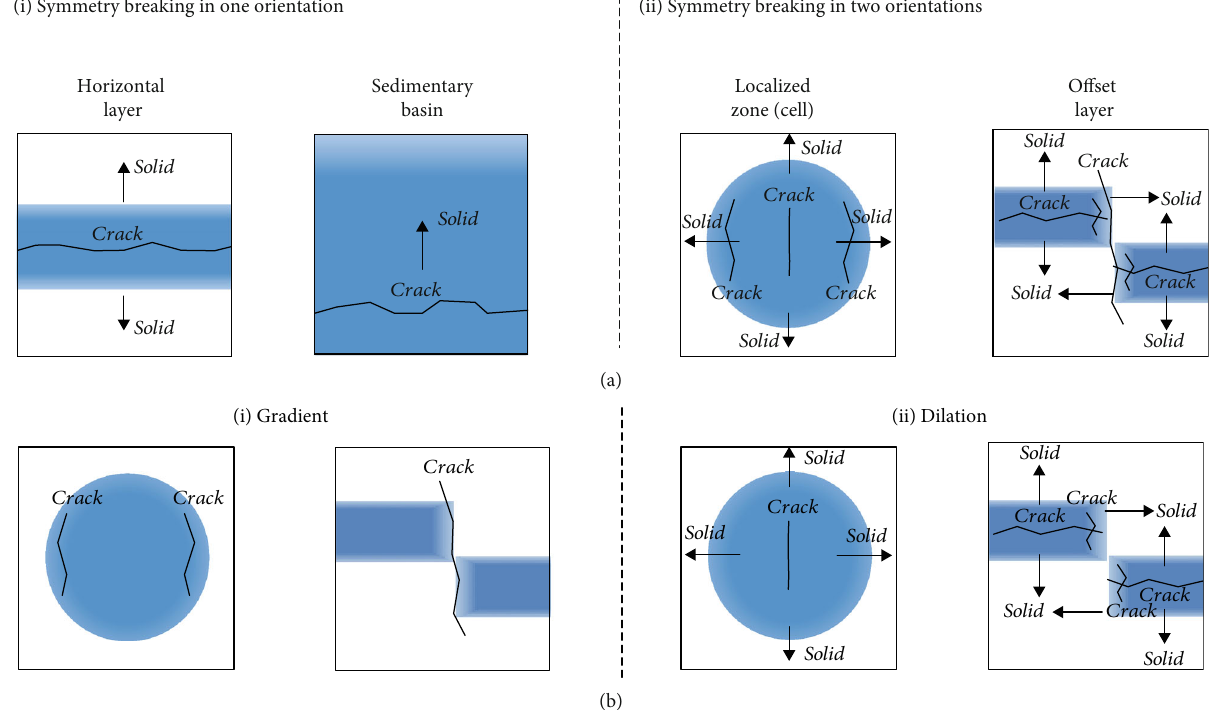
Figure 9: Illustration of the di ff erent geometries that produce variable fracture patterns. Fluid overpressure in blue color, cracks in black, and arrows showing the movement of the solid. (a) Hydrofracture symmetry depending on the geological scenario. (i) High fl uid pressure in a horizontal layer or a sedimentary basin and symmetry breaking in one orientation because the pressure gradients are aligned horizontally. The resulting patterns are horizontal hydrofractures. (ii) High fl uid pressure in a con fi ned zone or an o ff set horizontally aligned layer. Symmetry breaking in two orientations because both cases lead to variably aligned gradients and dilation in two directions. Hydrofractures develop as a function of pressure gradients and dilation, fi rst in the direction of the lowest e ff ective stress followed by brecciation of the layers. (b) Two processes produce hydrofractures: (i) pressure gradients at the rims of high-pressure zones and (ii) dilation of high-pressure